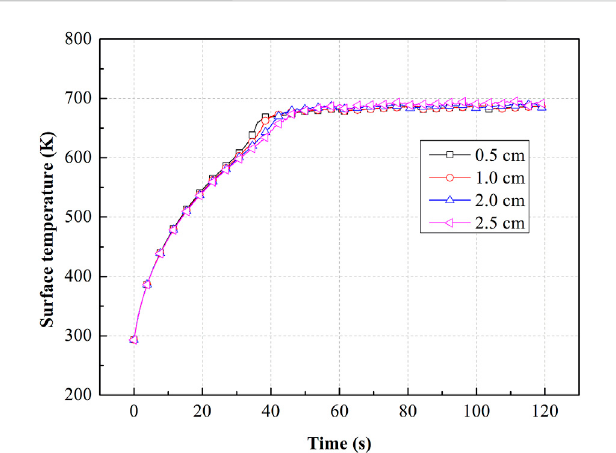
FIGURE 3 Theoretical calculation and experimental measurements ofsurface temperature under different radiant heat fl